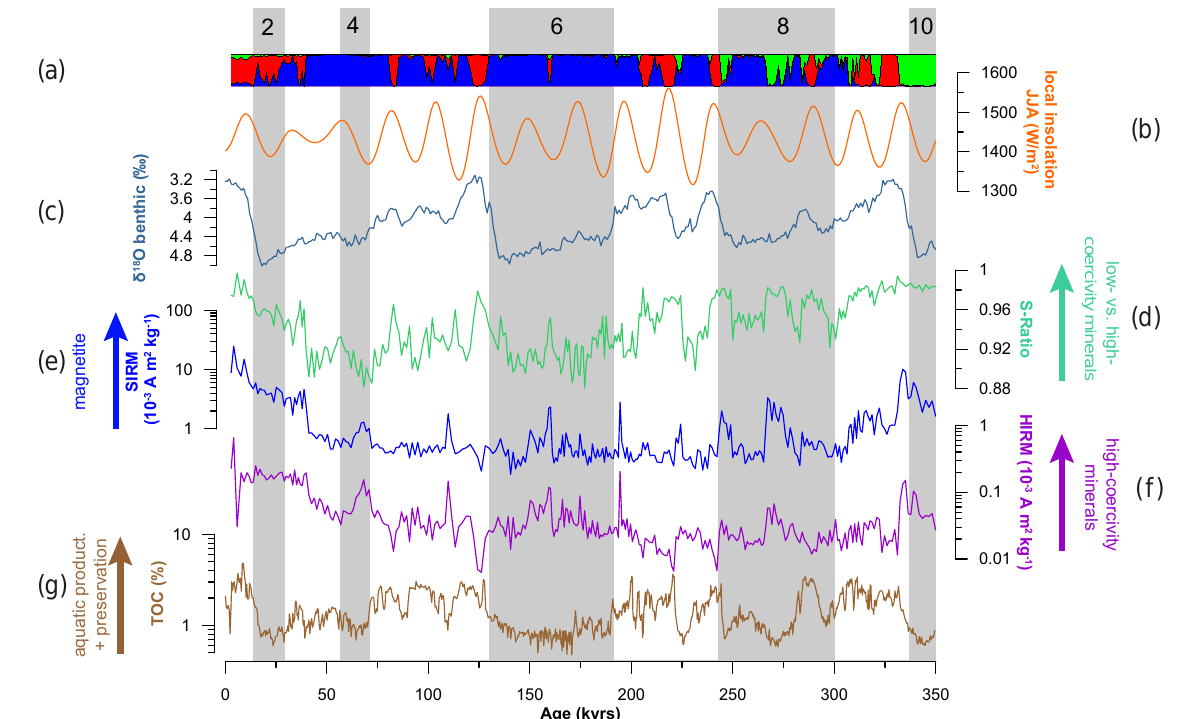
Figure 6. Cluster-membership coefficients (a) , rock-magnetic properties (d–f) and TOC concentration (g) for unit 1 compared to (a) summer insolation at Lake Ohrid (after Laskar et al., 2004) and (b) benthic δ 18 O stack (Lisiecki and Raymo, 2005). Changing magnetic mineralogy parallels glacial–interglacial variability and summer